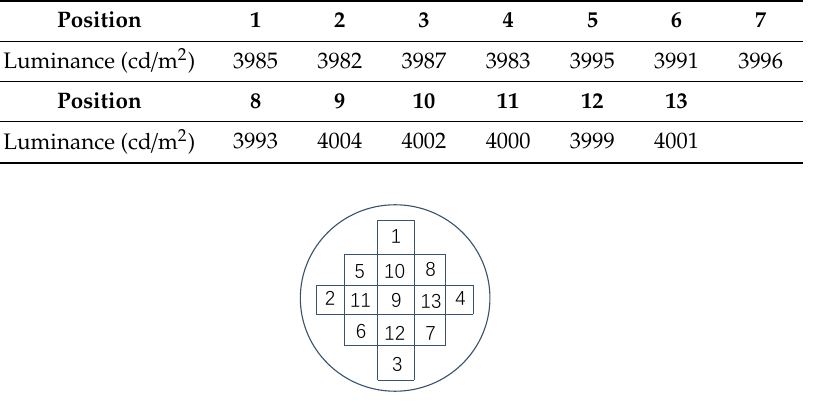
Figure 7. Schematic diagram of the measurement position.